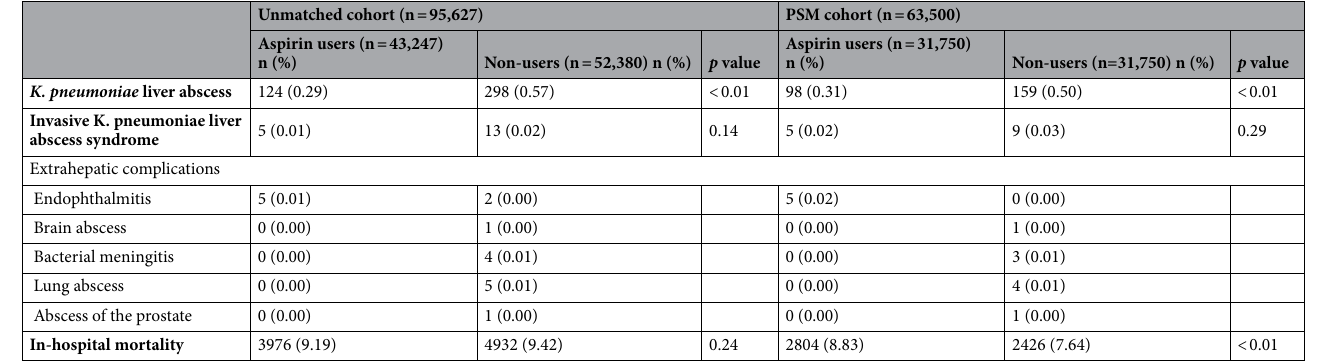
Table 3. Comparisons of incidences of K. pneumoniae liver abscess, invasive K. pneumoniae liver abscess syndrome and mortality between aspirin users and non-users in unmatched cohort and propensity-score matched (PSM) cohort.